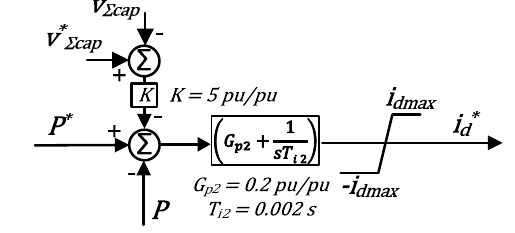
Figure 8. Active power control loop for FBMMC2.